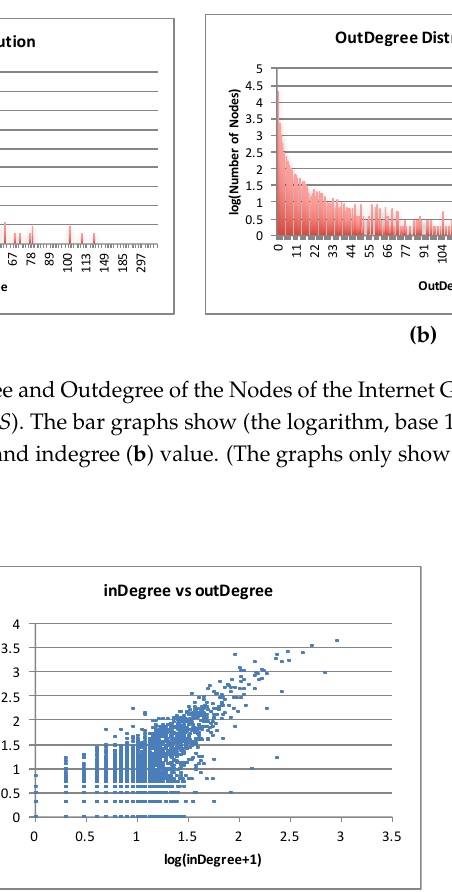
Figure 2. Indegree and Outdegree of the Nodes of the AS-level Intenet Graph from DIMES. The scatter plot shows the indegree and outdegree pairs of the AS nodes in logarithmic (base 10) scale. All the IDD games in the experiments presented in this section have this network